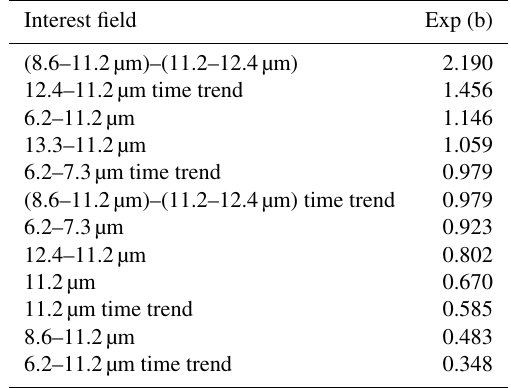
Table 8. Exp (b) values from the logistic regression (LR) model, which are odds ratios derived by SPSS at the significance level